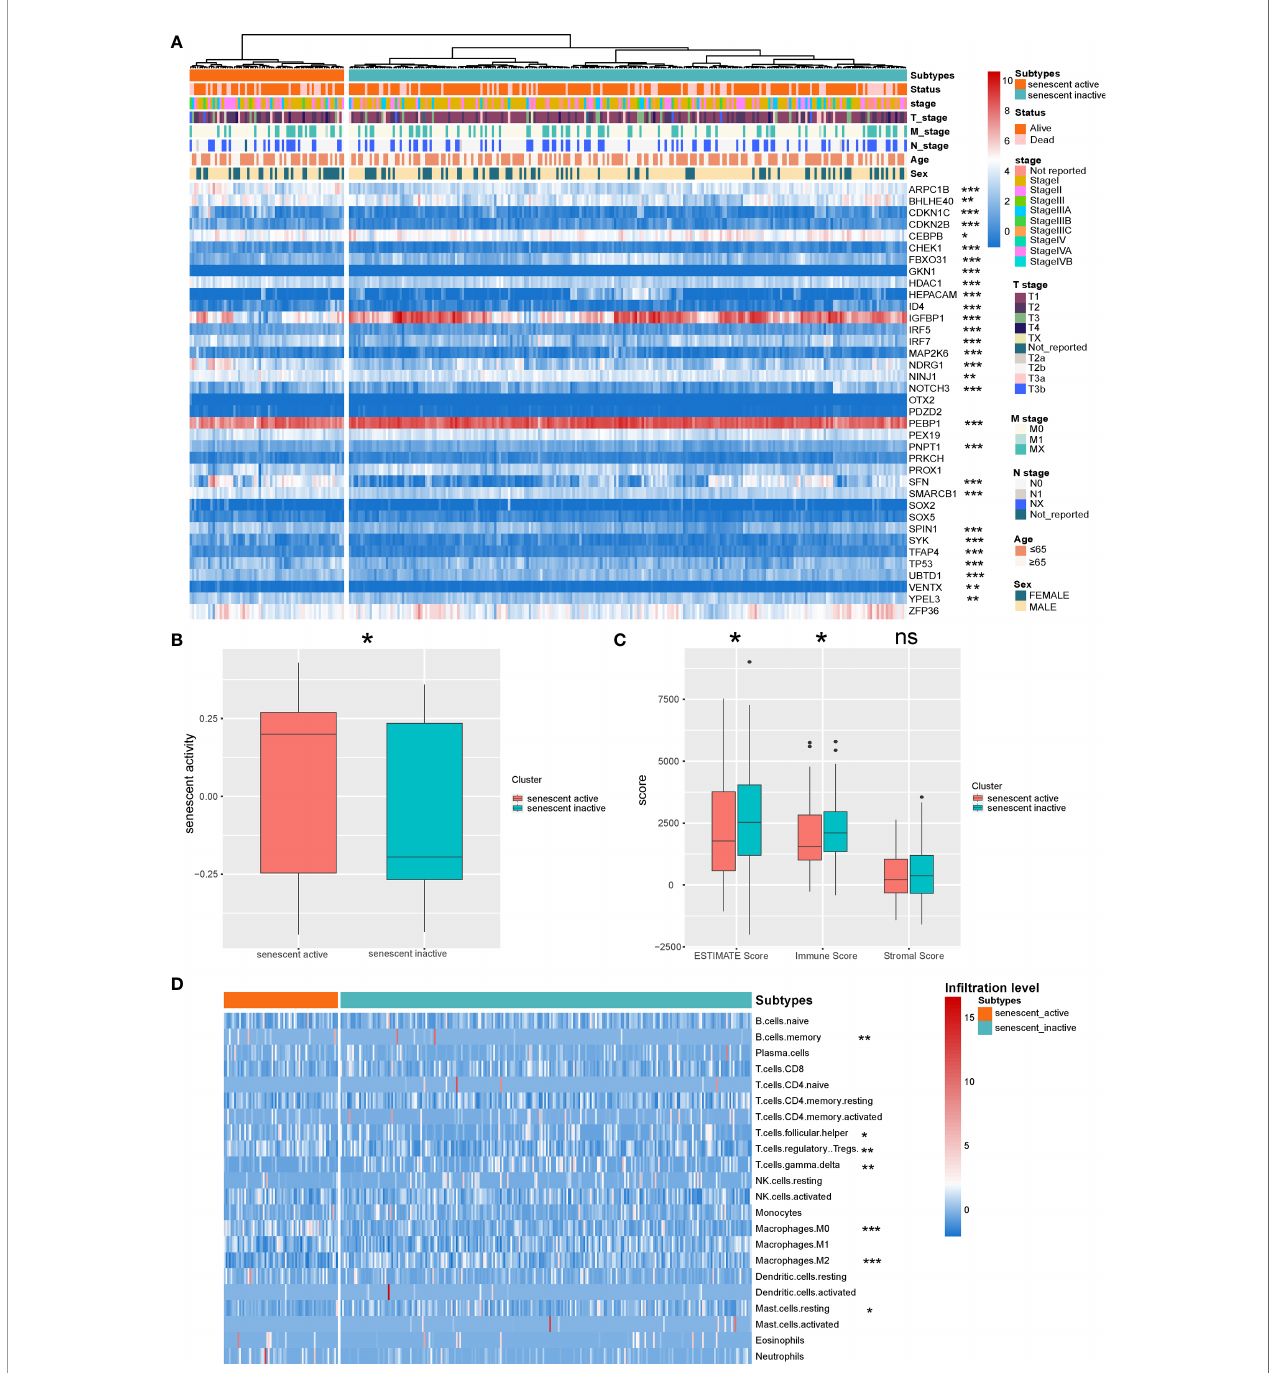
FIGURE 1 | Identi fi cation of the senescence-related HCC subtypes. (A) Landscape of the senescence-related HCC subtypes. (B) Comparison of the senescence activity of the two HCC subtypes. (C) Comparison of the ESTIMATE Score of the HCC subtypes. (D) Landscape of the immune in fi ltration level of the two subtypes. *P < 0.05, **P < 0.01, and ***P < 0.001. NS: Not Signi fi